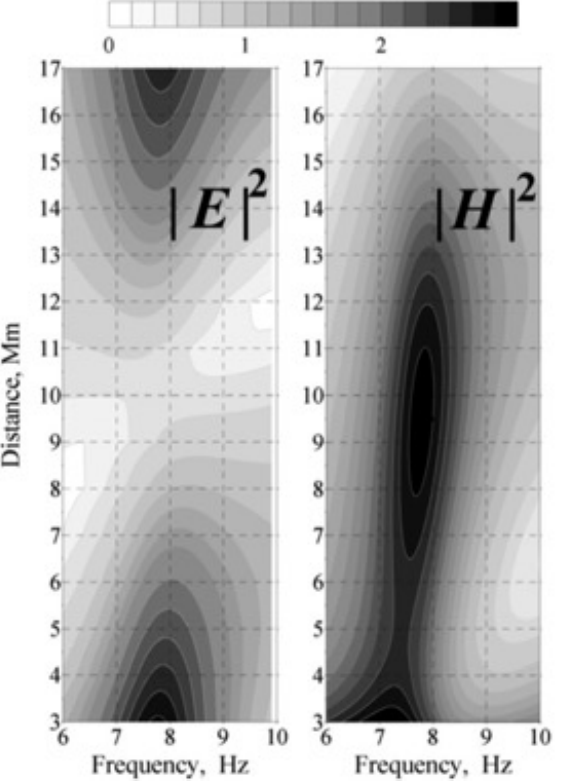
Figure 3. Power spectra of the electric filed E (left) and magnetic field H (right) in the vicinity of the first mode SR over the distance-fre- quency plane (received with the courtesy of Prof. A.P.